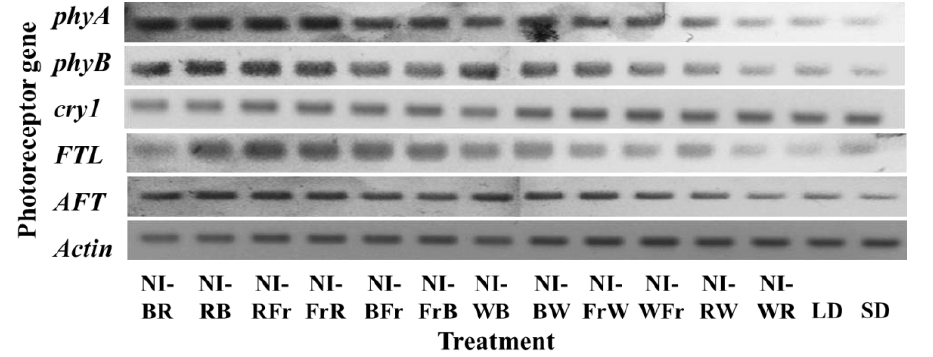
Figure 7. Effects of 10 µ mol · m − 2 · s − 1 PPFD night-interruption light (NIL) quality shifting on the expression of photoreceptor genes in geranium ( Pelargonium × hortorum L.H. Bailey ‘Ringo 2000 Violet’) measured at 40 days after treatment. Please refer to Figure 1 for detailed NIL qualities. Please refer to Table 1 for details of photoreceptor genes and Actin .